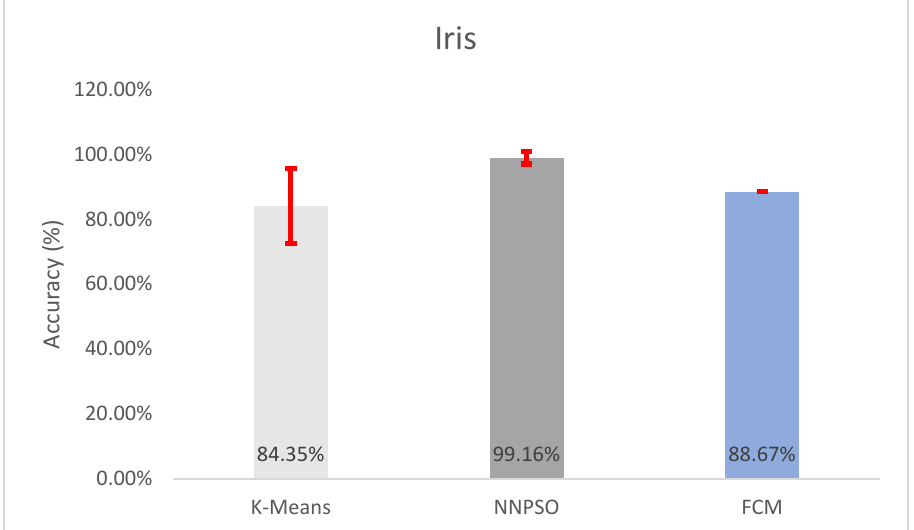
Figure 19. Ground truth vs. predicted labels from FNN-PSO algorithm on Sonar.